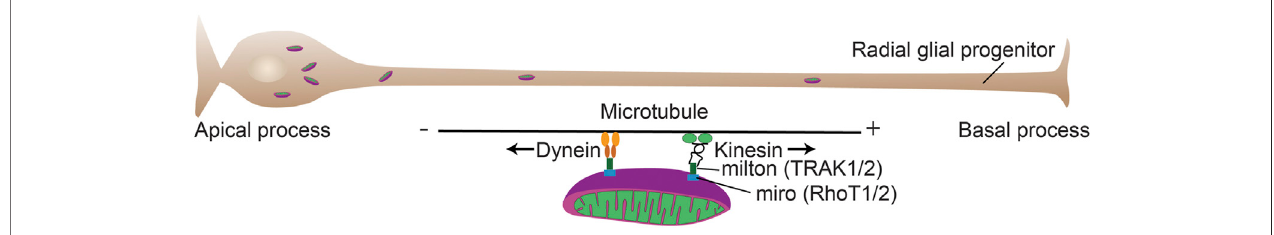
FIGURE4 | Mitochondrial mobility in cortical progenitors. Mitochondrial mobility iscritical fora number ofdevelopmental processes during forebrain development. Mitochondrial adaptor proteins couple mitochondria to motor proteins (TRAK and RhoT) that allow transport of the organelles along microtubules. The plus (+) end of microtubulesislargelydirectedtothebasalprocess(Tsaietal.,2010)andkinesintransportsgenerallytowardthe+endanddyneintransportstowardtheminus( − )end.